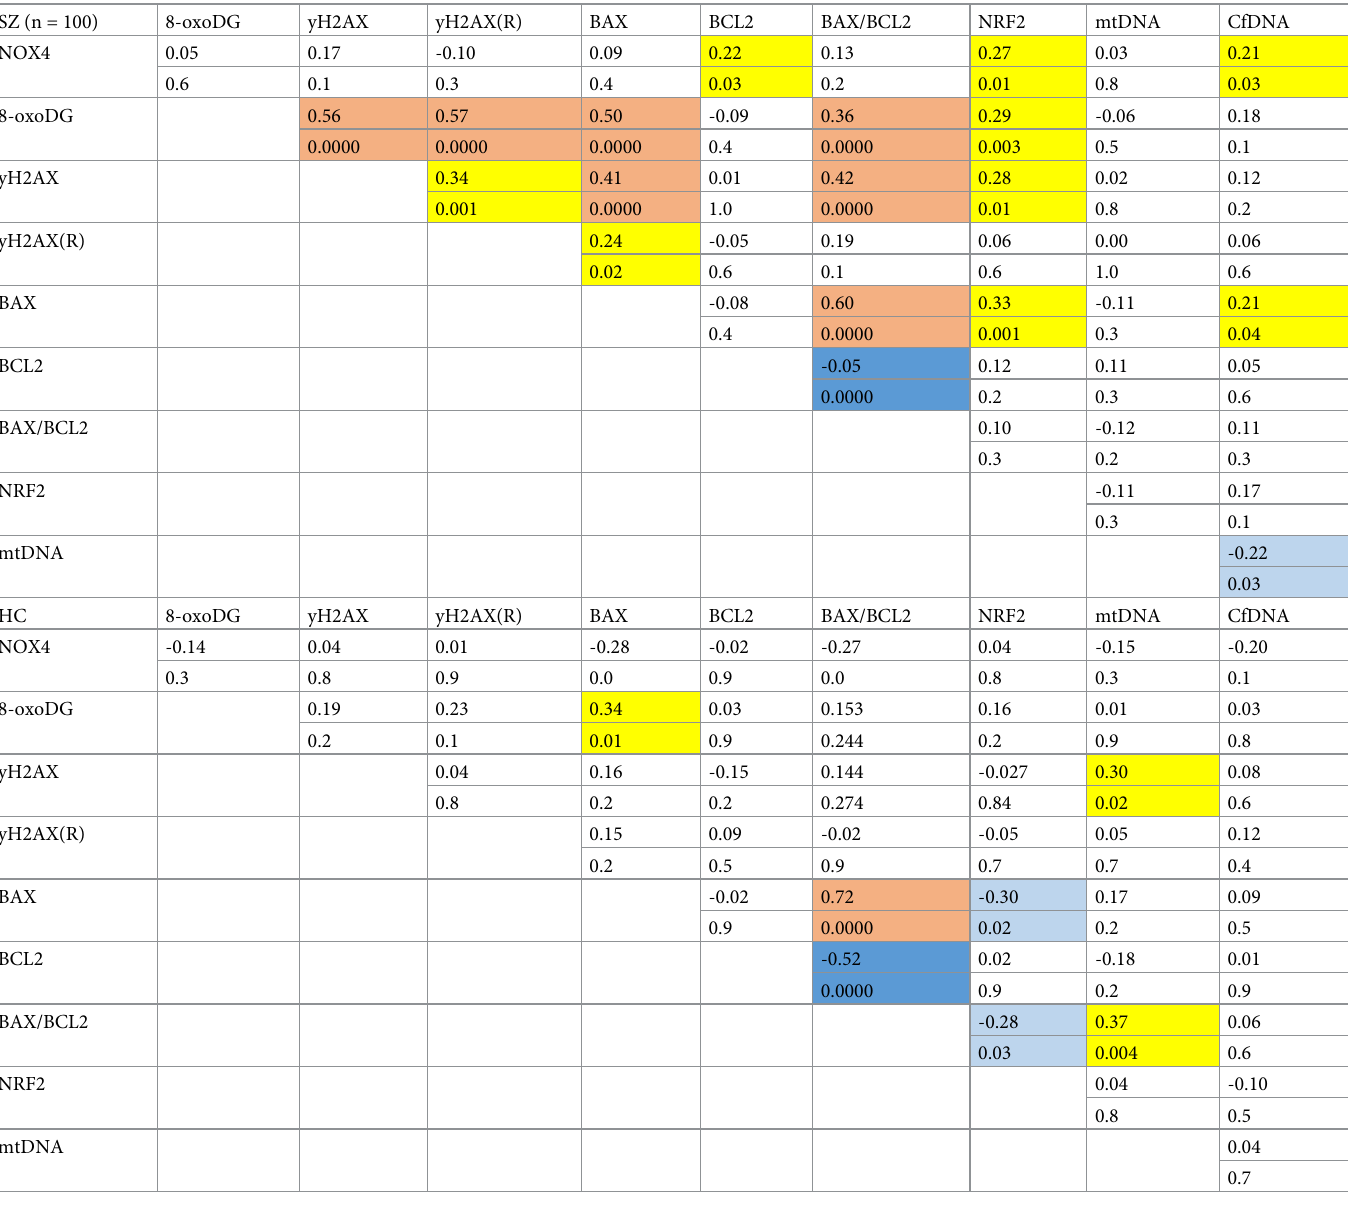
Table 2. Multiple-variable analysis (R and p) for SZ and HC